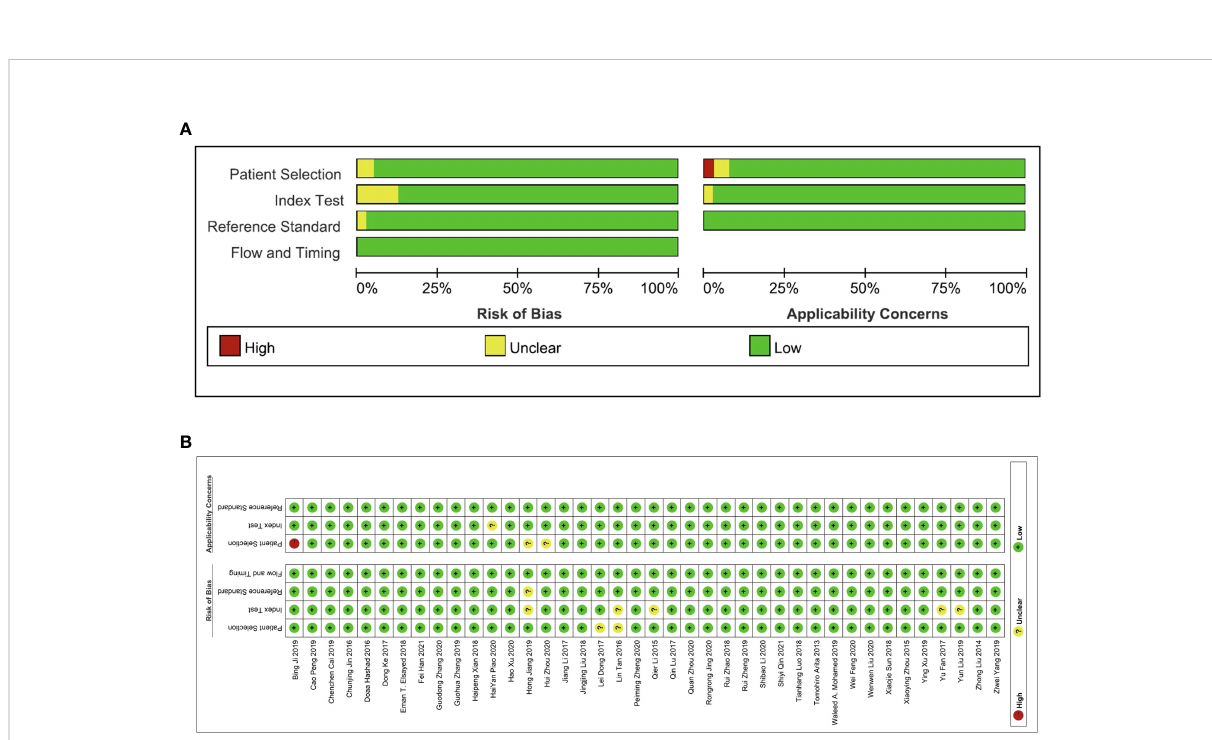
FIGURE 2 The quality assessment of the included studies via the QUADAS-2 tool. (A) Risk of bias and applicability concerns graph and (B) summary of quality